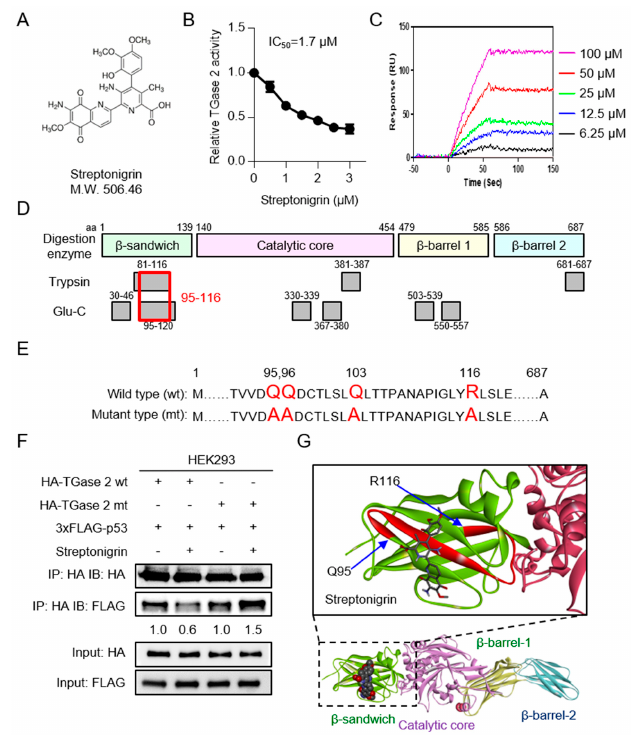
Figure 2. Identification and validation of streptonigrin as a TGase 2 inhibitor. In RCC, streptonigrin competes with p53 for binding to the N-terminus of TGase 2. ( A ) Chemical structure of streptonigrin. ( B ) The IC 50 value of streptonigrin against TGase 2 is 1.7 μ M. For analysis, guinea pig liver TGase 2, succinylated casein, and 14 C-putrescine were used as competitors of streptonigrin. ( C ) SPR analysis of the interaction between streptonigrin and TGase 2. Sensograms showing binding of streptonigrin to histidine-tagged TGase 2 proteins immobilized on the tris-NTA poly ProteOnTM HTE sensor chip (binding was measured using the ProteOnTM XPR36 biosensor). The dissociation constant was calculated from association and dissociation sensograms obtained using 6.25 (black), 12.5 (blue), 25 (green), 50 (red), and 100 (purple) μ M streptonigrin. The Kd value was calculated as 0.7 μ M. ( D ) Summary of peptide-matching analysis. To identify the binding site of streptonigrin on TGase 2, TGase 2 and streptonigrin were incubated for 30 min at RT, followed by mass spectrometry (MS) analysis. The mass coverage of the samples revealed a difference between TGase 2 alone and the combination of TGase 2 plus streptonigrin. The streptonigrin binding-mediated masking region of TGase 2 is denoted by underlining (aa 81–116, 381–387, and 681–687 after digestion in trypsin solution, and aa 30–46, 95–120, 330–339, 367–380, 503–539, and 550–557 after digestion with Glu-C). The merged streptonigrin binding-mediated masking region of TGase 2 after trypsin and Glu-C digestion covers aa 95–116. ( E ) To test whether streptonigrin competes with p53 for binding to the N-terminus of TGase 2 (aa 95–116) through a charged interaction, we constructed a HA-pcDNA3.1/TGase 2 quadruple-point mutant-type plasmid (Q95A, Q96A, Q103A, R116A). The p3xFLAG p53 plasmid was constructed based on the p3xFLAG vector. ( F ) HEK293 (human embryonic kidney 293) cells were co-transfected with wild-type or mutant HA-TGase 2 plus the FLAG-p53 plasmids, treated with streptonigrin (100 nM) for 24 h and harvested prior to analysis of binding between TGase 2 and p53 by immunoprecipitation (IP) and immunoblotting (IB). IP of TGase 2 was performed using an anti-HA antibody and IB of p53 was performed using an anti-FLAG antibody. Streptonigrin-mediated inhibition of TGase 2 binding to p53 was analyzed by densitometry. ( G ) A complex model of TGase 2 bound to streptonigrin. The overall structural domain of TGase 2 and the streptonigrin docking site are shown. Streptonigrin docks to the β -sandwich domain of TGase 2. The expanded solid box shows the region of TGase 2 that harbors the streptonigrin binding site (aa 95–116). Streptonigrin is shown within the binding site (black stick backbone). The red loop region denotes the amino acids participating in the binding of streptonigrin (identified by MS analysis). The docking models were prepared using Discovery studio ver.